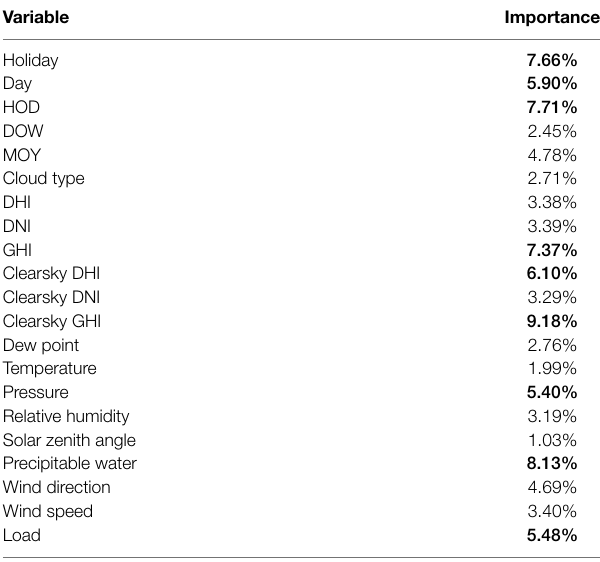
TABLE 4 | Importance of variable importance for past inputs.